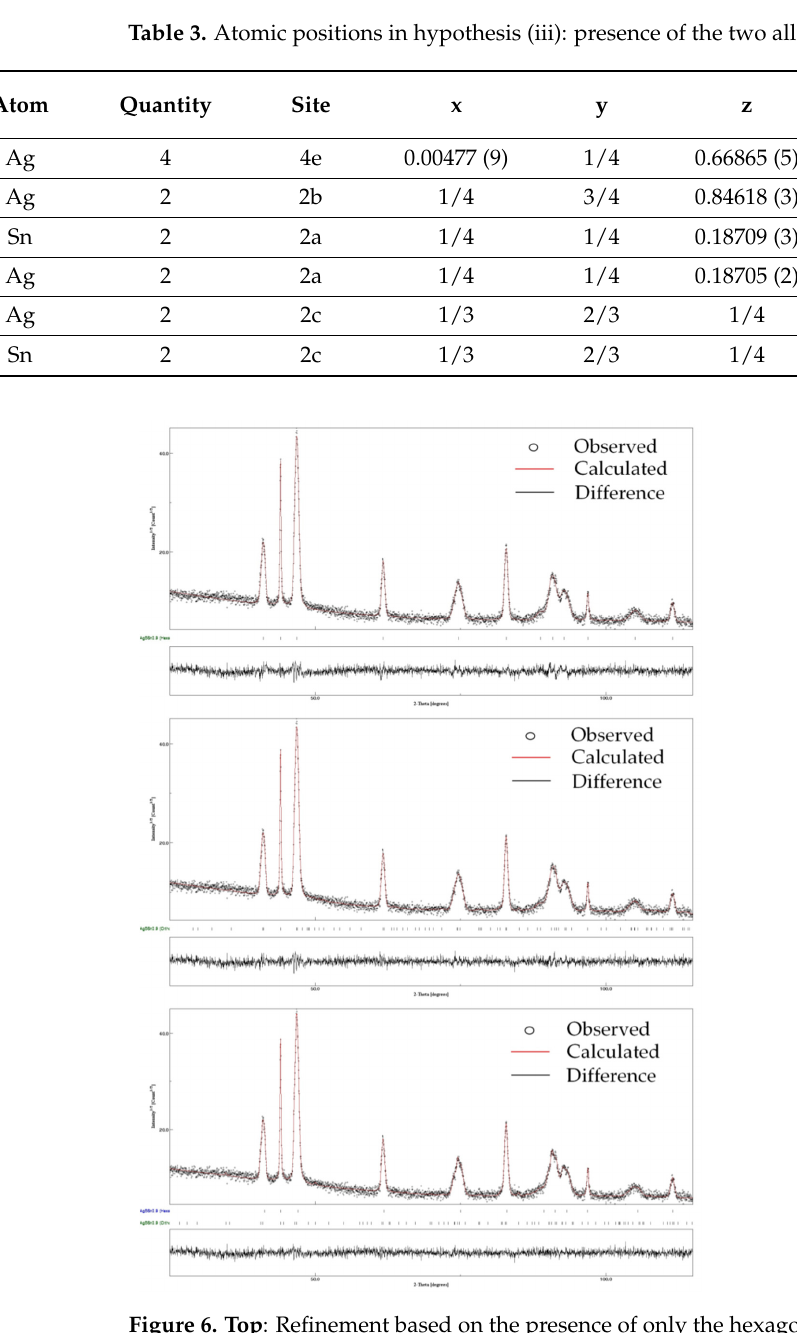
Figure 6. Top : Refinement based on the presence of only the hexagonal variety; middle : refinement based on the presence of only the orthorhombic variety; bottom : refinement based on the presence of the hexagonal variety and the orthorhombic variety.